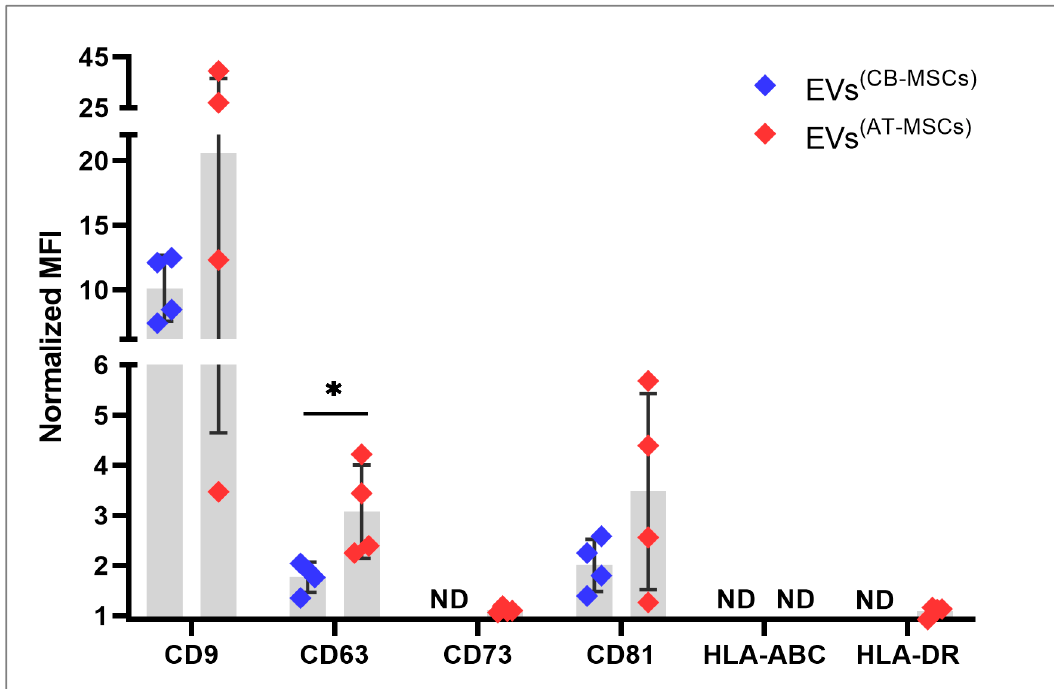
Figure 4. CB- and AT-MSC-derived EVs display a distinct surface marker profile. Detection of the surface marker proteins CD9, CD63, CD73, CD81, HLA-ABC, and HLA-DR using flow cytometry on EV preparations. The data are presented as means ± SD of normalized mean fluorescence intensities (MFIs), which were calculated as the ratio of the geometric MFI of EV samples (beads + EVs + antibodies) to control samples (beads + antibodies). Statistical analysis was performed by the Mann-Whitney test with * p < 0.05. ND indicates not detected. EVs from four different donors per cell type were included.